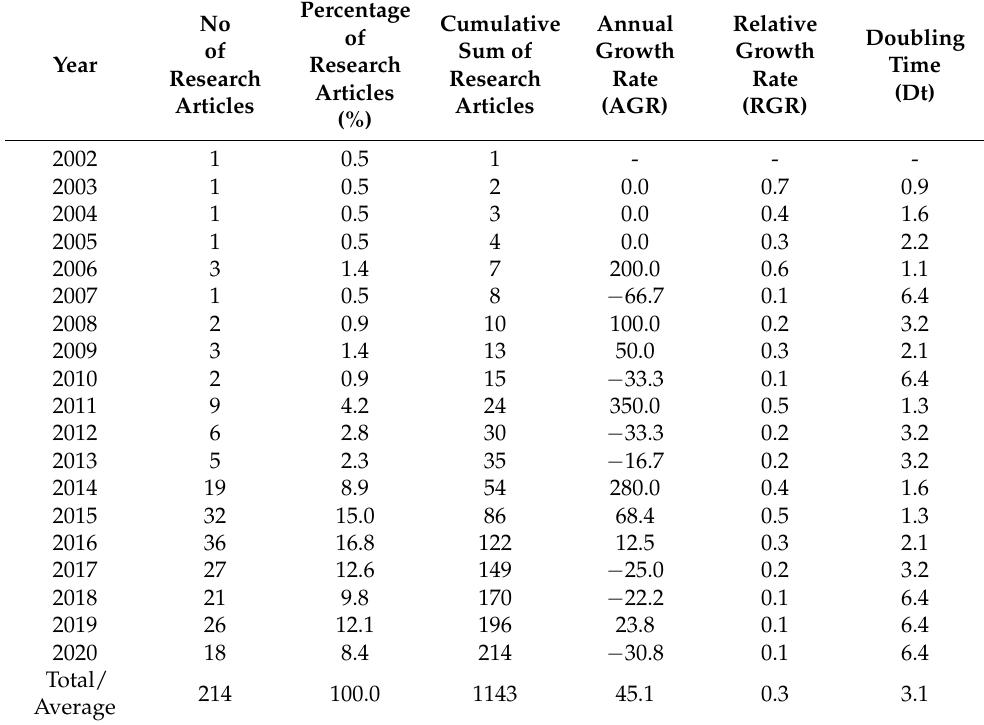
Table 2. Annual production and growth of research